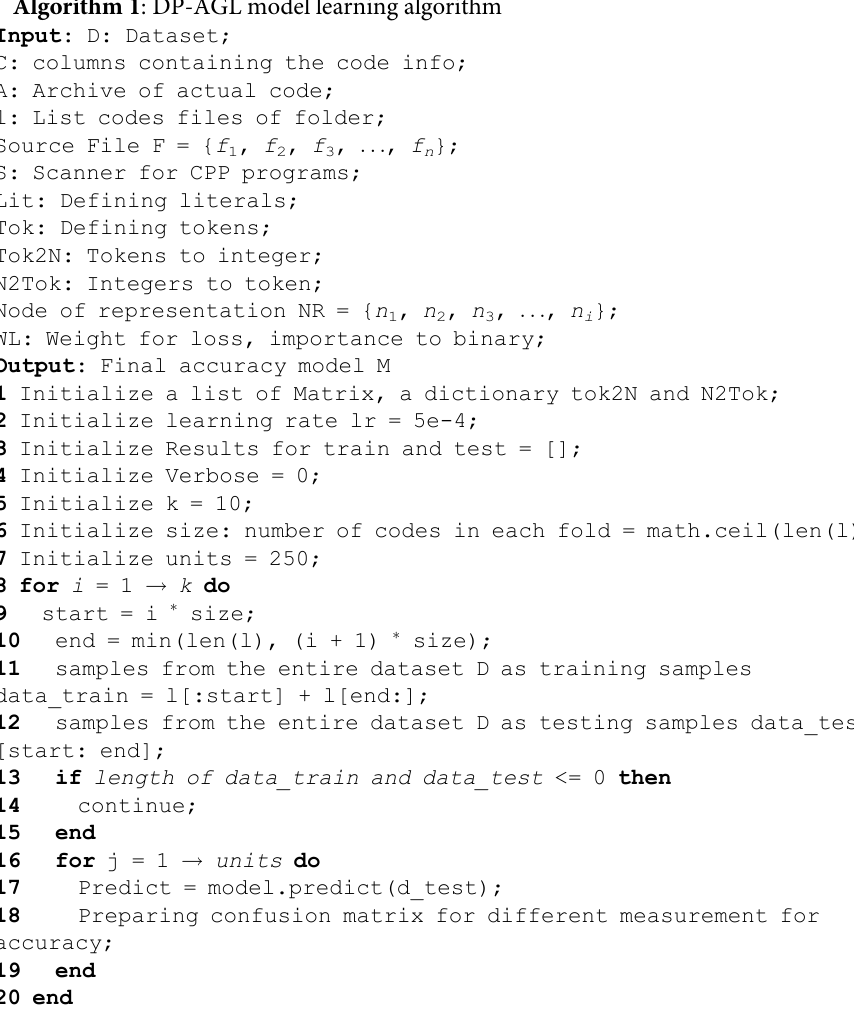
Algorithm 1 : DP-AGL model learning